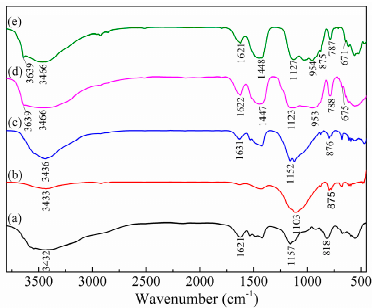
Figure 6. FT-IR spectrums for the raw materials (a-MSWIFA, b-CFBCFA), ground mixture (c), and solidified bodies (d-CFBCFA based solidified bodies, e-Cement based solidified bodies).